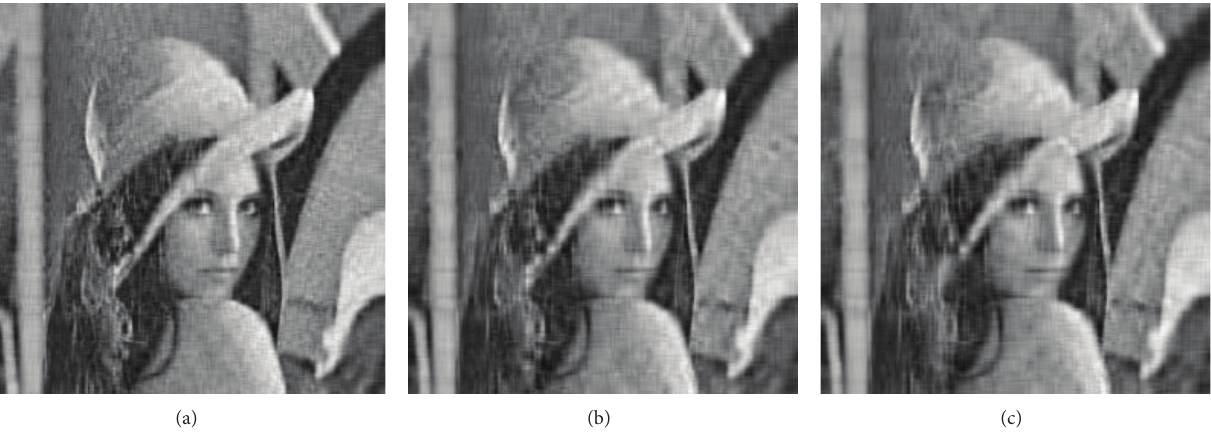
Figure 3: Image compression by SVD method with different rank 𝑑 : (a) 𝑑 = 40 ; (b) 𝑑 = 30 ; and (c) 𝑑 = 20